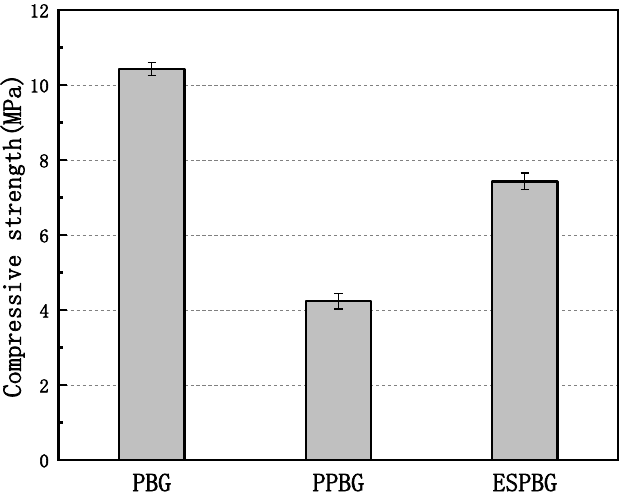
PBG PPBG ESPBG Figure 6. Compressive strengths of the PBG, PPBG, and ESPBG. Under the same mixture ratio, the compressive strength of the PPBG decreased by 59.50% compared with that of the PBG due to the pore structure optimisation of the PBG by the water–paste ratio and the air-entraining agent, which resulted in an increase in porosity and a decrease in strength. Compared with those of the PPBG and the PBG, the compressive strength of the ESPBG increased by 75.65% and decreased by 28.85%, respectively, due to the phase transition temperature of the paraffin wax having a small change range. The PPBG’s porosity was also reduced after filling into the pore structure at a normal temperature. It existed in solid form, as can also be seen from the microstructure in Figure 6. Compared with the PBG, part of the strength decreased after the paraffin filling. This was caused by some of the closed pores in the PBG, which could not be filled. However, compared with the existing energy-storage gypsum materials, the ESPBG has better compressive strength and a better decline rate. Figure 7a,b present the comparison results, showing that the ESPBG has a certain applicability.